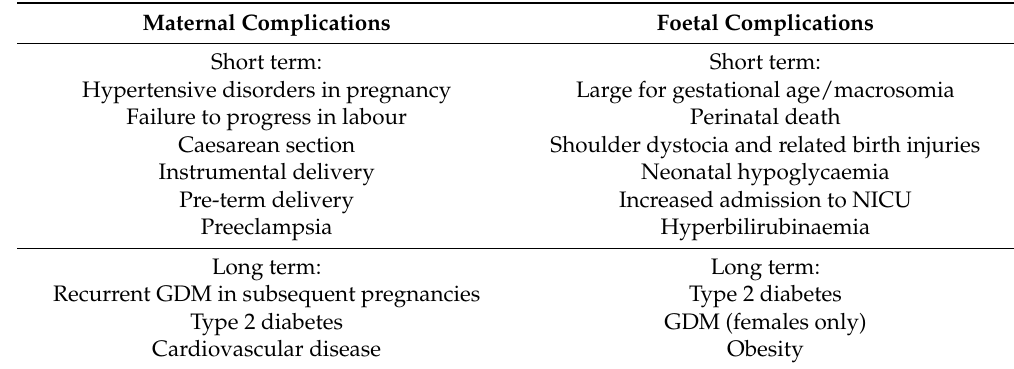
Table 1. Maternal and foetal complications of